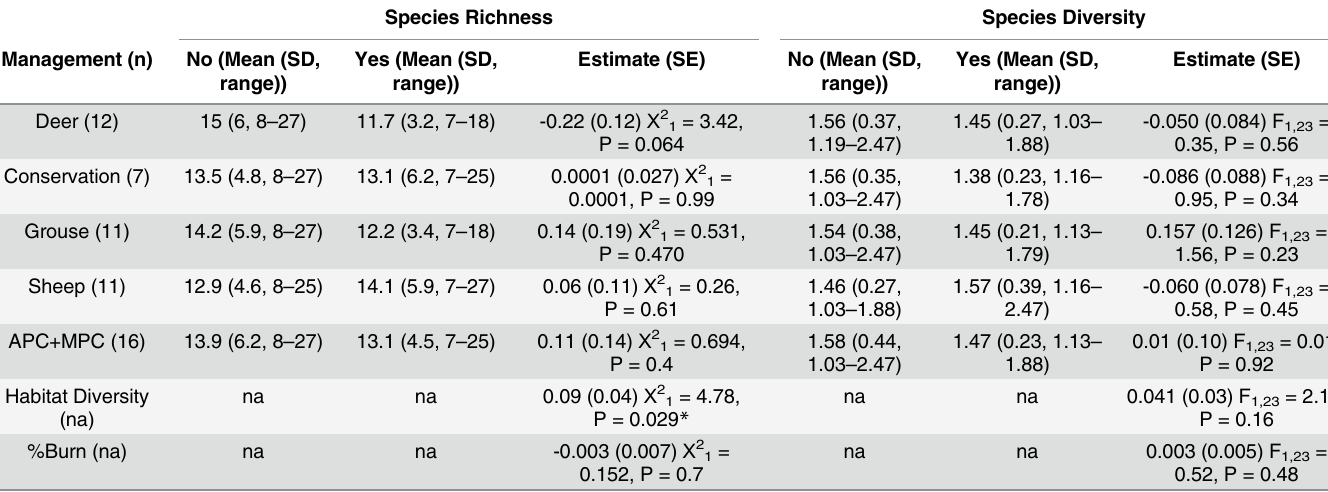
Table 3. The effects of dominant management objectives and management activities on avian species richness and